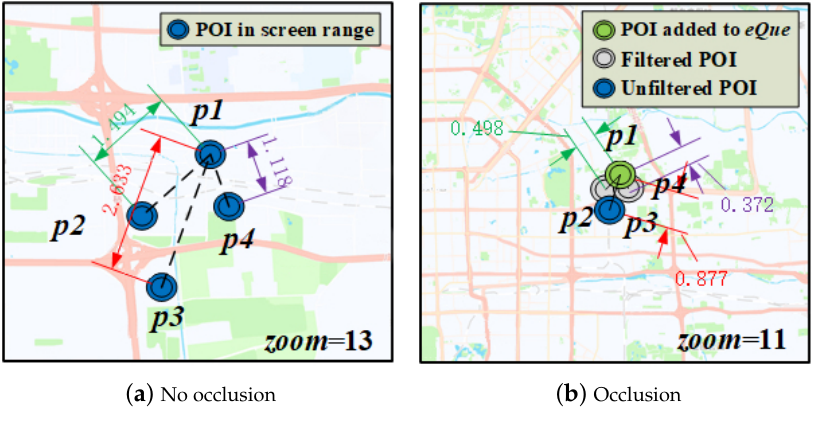
Figure 4. Examples of overlapping